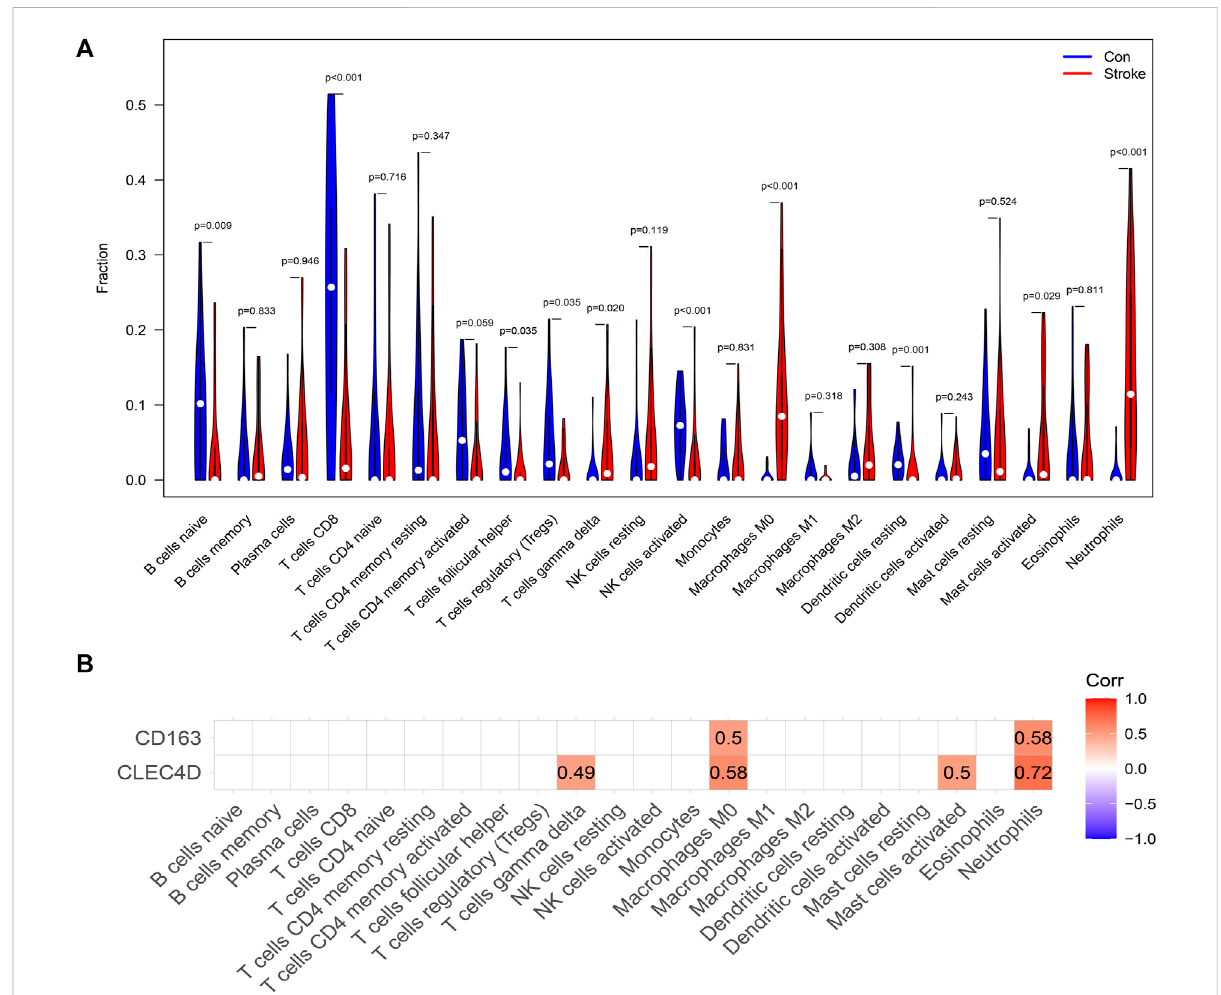
FIGURE 6 Peripheral Blood Immune Cell In fi ltration in IS. (A) Violin plot of 22 kinds of immune cells ’ differentially in fi ltrated fractions in peripheral blood between healthy controls and IS patients. (B) Heatmap showing the correlation between IS immune-related biomarkers and 22 circulating immune cells. Correlation coef fi cients were calculated using Spearman ’ s correlation analysis. The correlation was interpreted primarily according to the magnitude ofthecorrelation coef fi cient: Corr > 0.70indicatesastrongcorrelation;Corrof0.50 – 0.70indicatesamoderatecorrelation;Corrof 0.30 – 0.50 indicates a weak-moderate correlation, and Corr < 0.30 indicates a weak